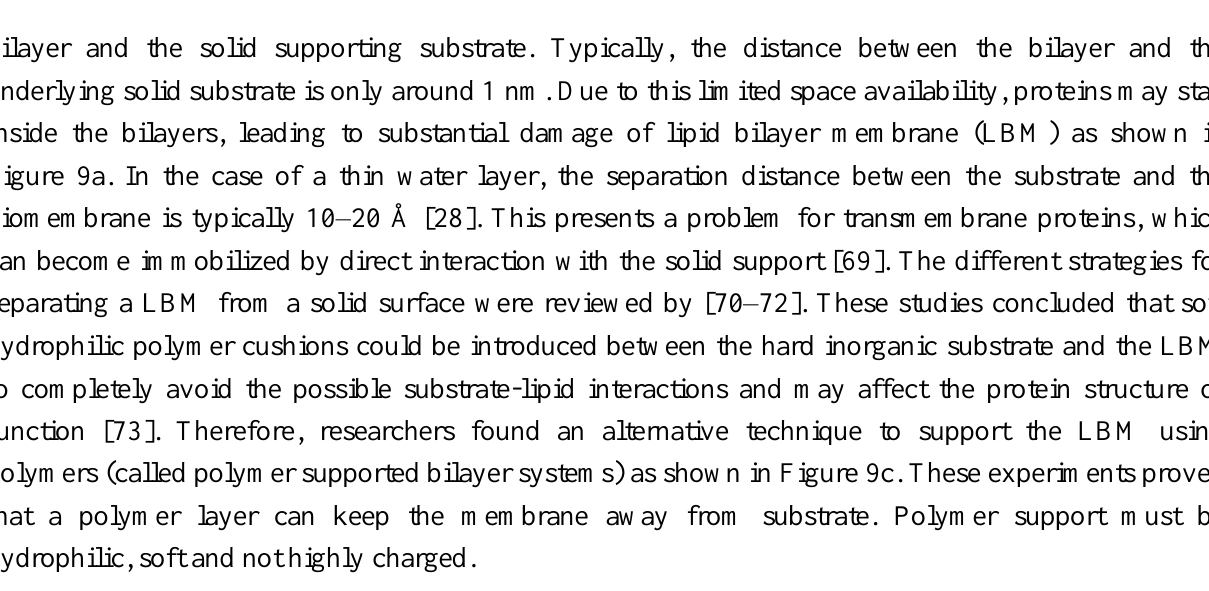
Figure 9. Incorporation of a protein in lipid bilayer membrane with polymer cushion on solid substrate. ( a ) Denaturation of transmembrane protein when comes in contact with substrate; ( b ) A polymer cushion; ( c ) Polymer cushion protects the protein from the substrate